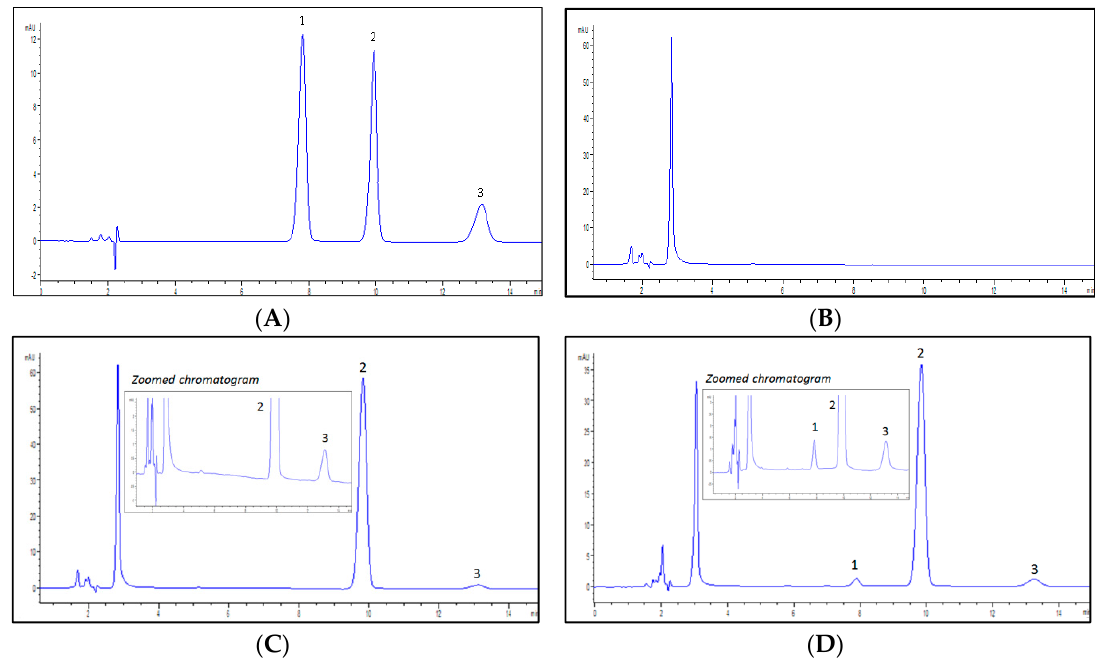
Figure 1. Representative chromatograms detected at λ = 267 nm. ( A ) a solution containing a mixture of zidovudine glucuronide (ZDVG), zidovudine (ZDV) and internal standard, 4-methylumbelliferone glucuronide (4MUG) at concentration of 150 µM. ZDVG, ZDV and 4MUG were eluted at 7.9, 9.9 and 13.1 min, respectively; ( B ) a HLM incubation matrix solution. No peaks were detected; ( C ) a HLM incubation assay in the absence of UDPGA. No metabolite (ZDVG) peak was detected whilst 4MUG was eluted at 13.1 min; ( D ) a HLM incubation assay in the presence of UDPGA. ZDVG and 4MUG were detected at 7.9 min and 13.1 min. (1) ZDVG; (2) ZDV; (3) 4MUG.